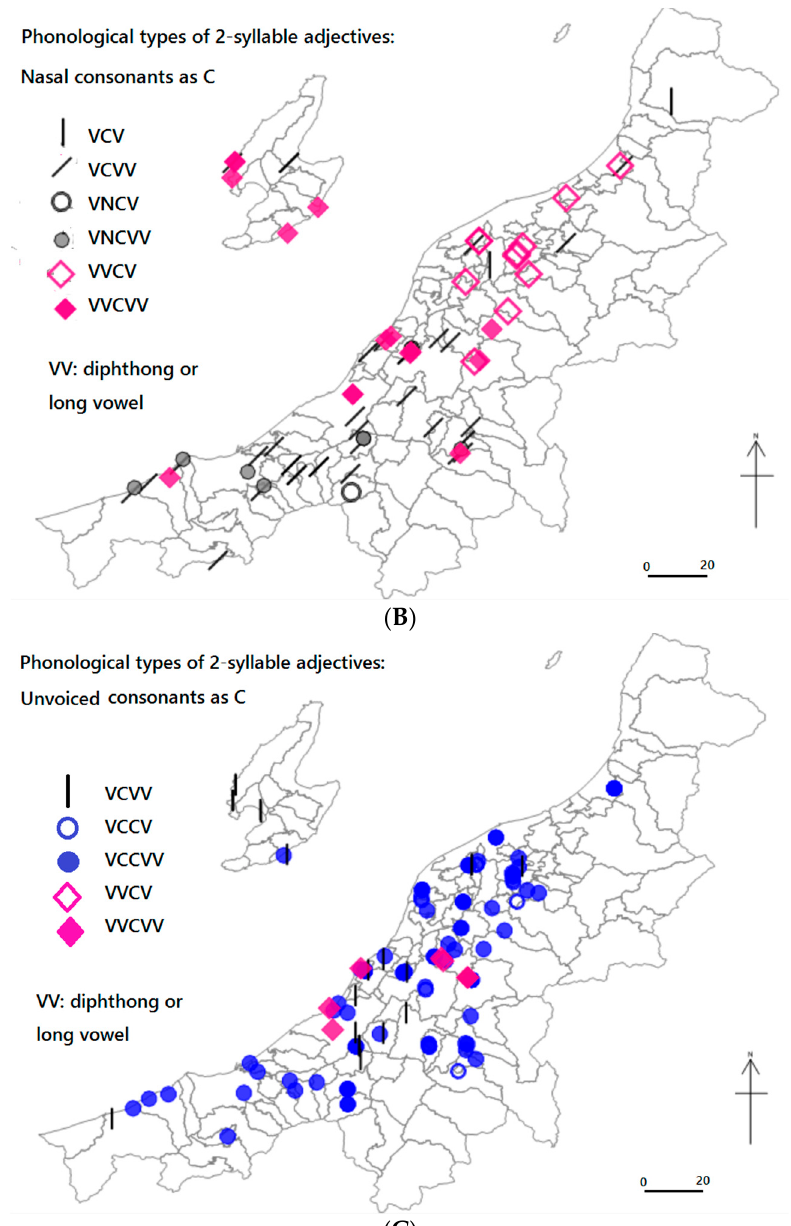
Figure 6. ( A ) Phonological types of two-syllable adjectives (voiced consonants as C): Toyama data. ( B ) Phonological types of two-syllable adjectives (nasal consonants as C): Toyama data. ( C ) Phonological types of two-syllable adjectives (unvoiced consonants as C): Toyama data.